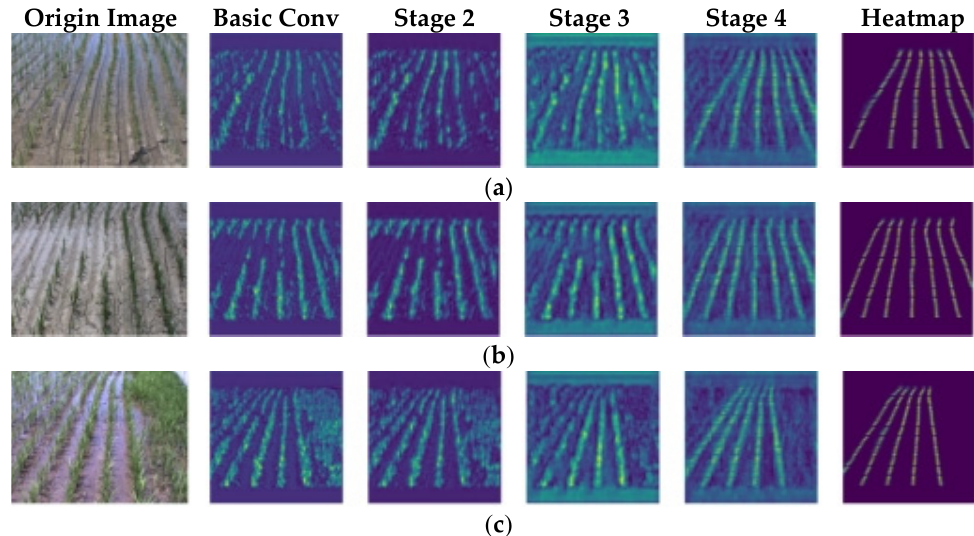
Figure 8. Results of feature layer visualization in different scenes: ( a ) Normal scene; ( b ) Lack of seedling scene; ( c ) Weed scene.